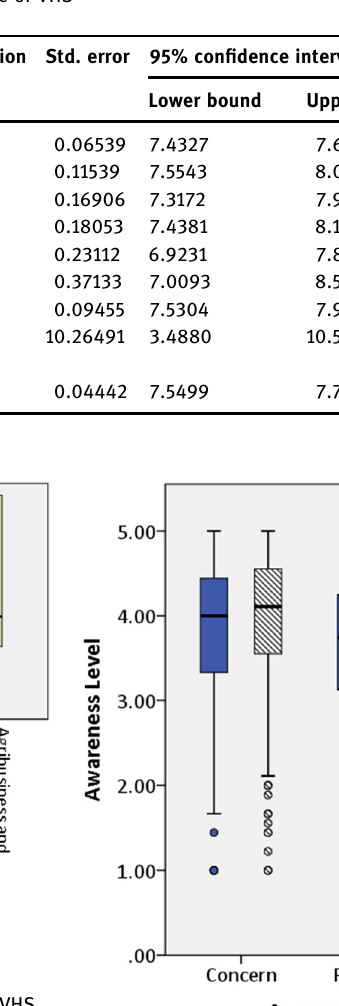
Table 13: Descriptive of knowledge level by areas of expertise of VHS